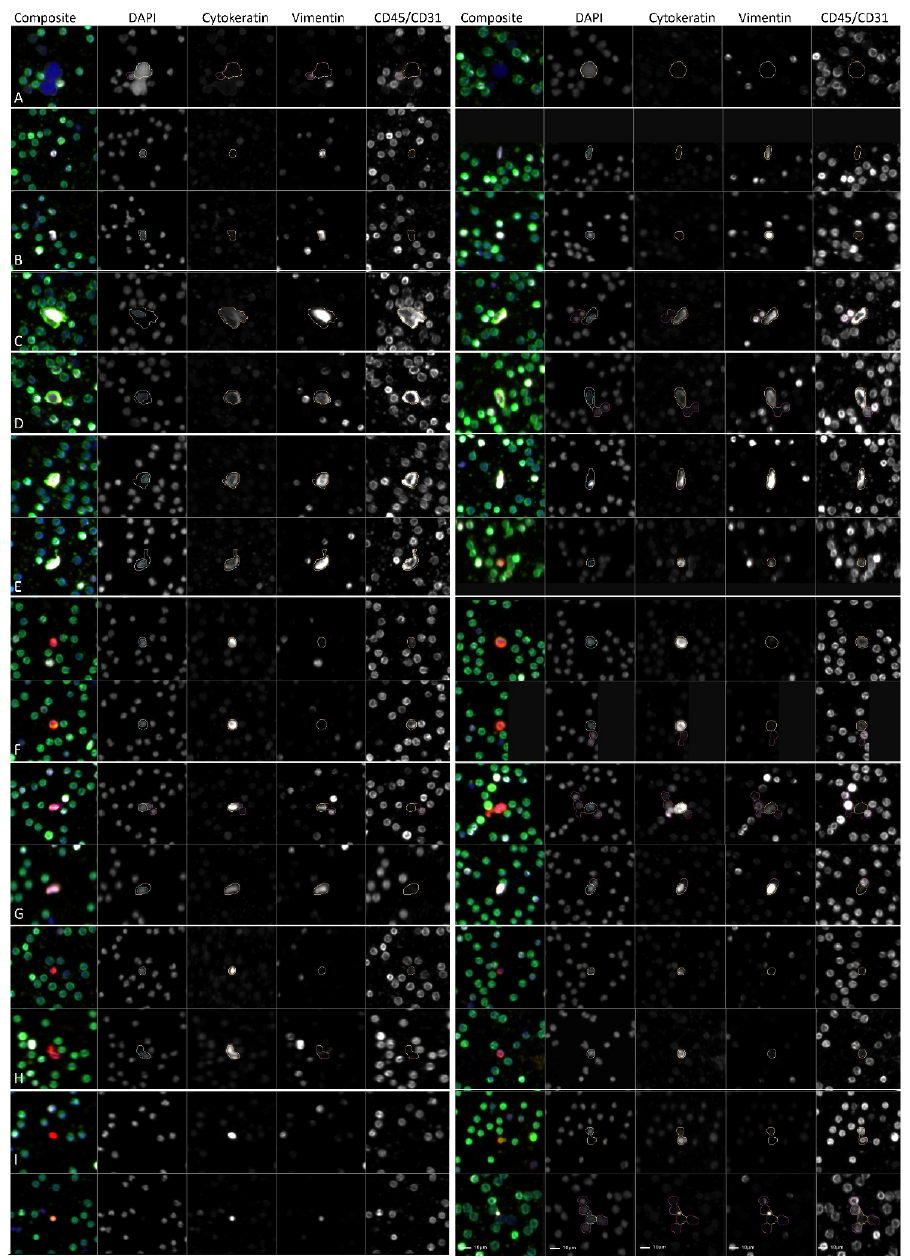
Figure 1. Gallery of representative rare events detected in PB samples collected from patients diagnosed with UTUC (1326.20 ± 344.42 cells/frame) prior to surgery or NDs (1472.64 ± 343.62 cells/frame) with no known pathology by HDSCA3.0. ( A – H ) rare cells and ( I ) LEVs. ( A ) DAPI only; ( B ) Vim; ( C ) CD45/CD31; ( D ) Vim|CD45/CD31; ( E ) CK|Vim|CD45/CD31; ( F ) CK|CD45/CD31; ( G ) mes.CTC; ( H ) epi.CTC; ( I ) LEVs (top left: CK only; bottom left: CK|Vim|CD45/CD31; top right: CK|CD45/CD31; bottom right: CK|Vim.) Blue: DAPI, Red: CK, White: Vim, Green: CD45/CD31. Images taken at 100× magnification. Scale bar = 10 µm.